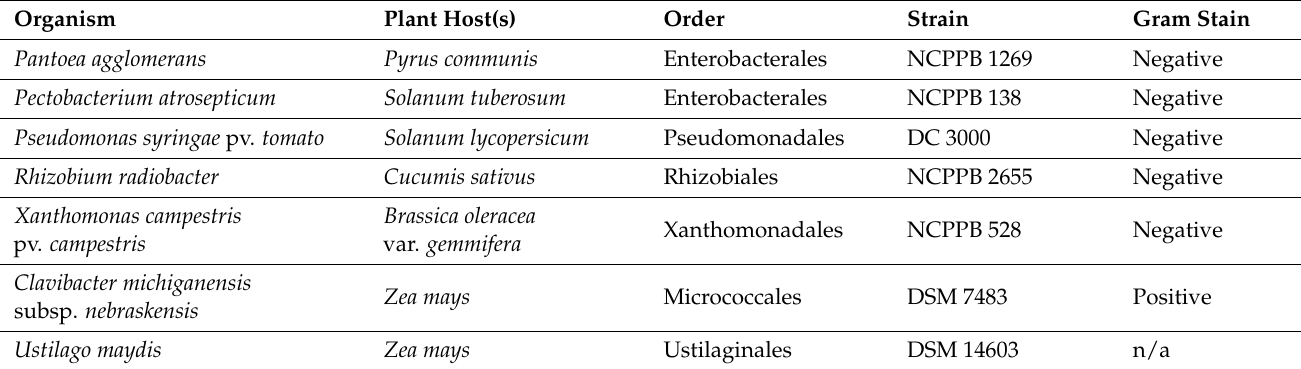
Table 2. Prey phytopathogen strains